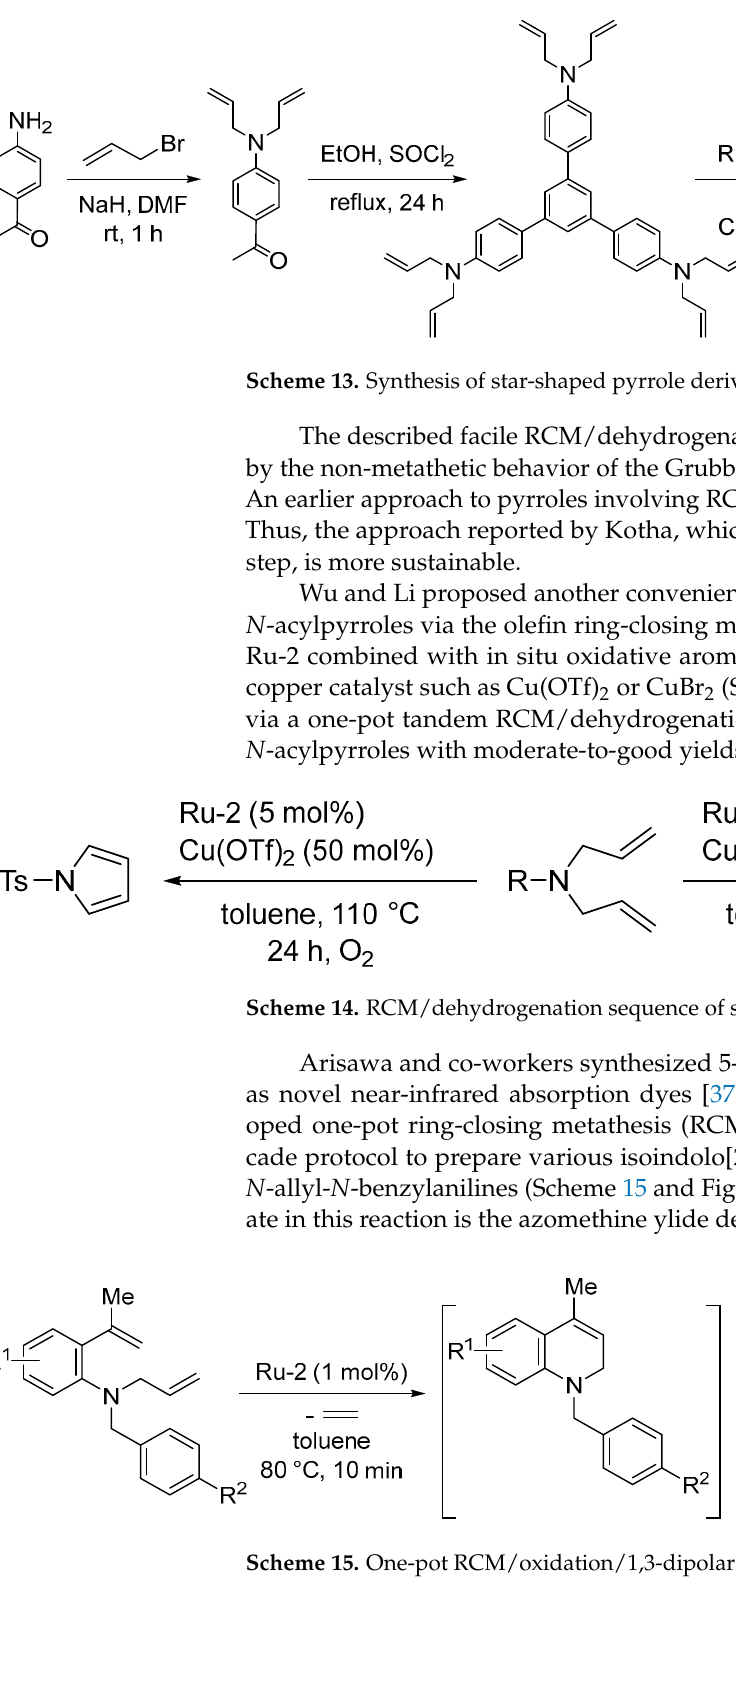
Figure 2. Scope of products obtained by one-pot RCM/oxidation/1,3-dipolar cycloaddition proto- col. In order to understand a structure and absorption − wavelength relationships, the authors performed calculations by using a time-dependent density functional theory (TD-DFT). Whiting and Carboni showed a different approach to the synthesis of pyrroles [38]. In the first step, they performed ring-closing enyne metathesis (RCEM), followed by cross-metathesis (CM) with vinylboronic esters to form a large spectrum of cyclic dienyl boronic esters (Scheme 16). Scheme 16. Synthesis of cyclic dienyl boronic esters via an RCEM/CM sequence.